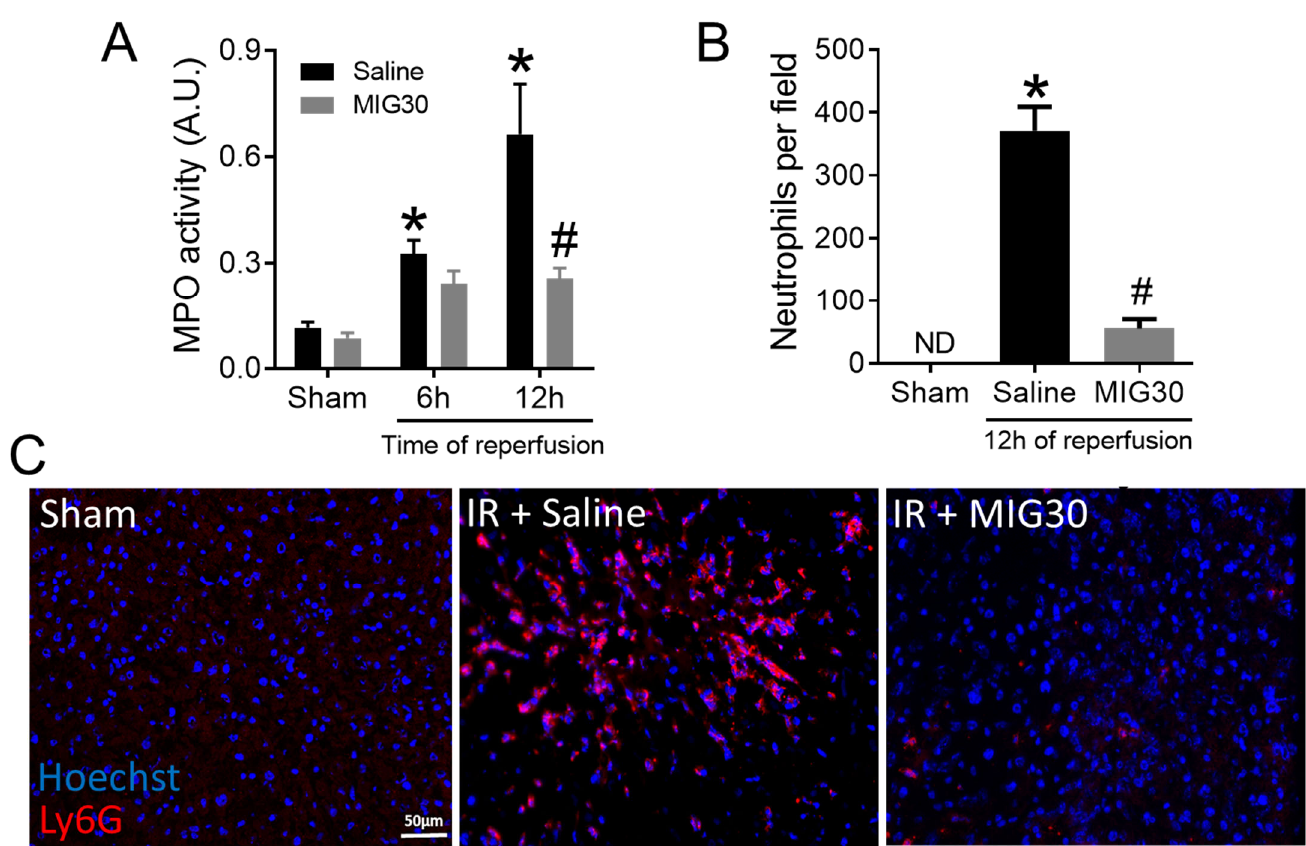
Figure 3. MIG30 treatment impairs neutrophil recruitment during liver IRI. ( A ) Liver MPO activity in mice subjected to liver ischemia-reperfusion injury (IRI). Sham operated mice were used as control. IRI mice were treated i.v. with saline vehicle or with MIG30 (100 µ g 15 min before the reperfusion and again 6 h later). ( B , C ) Immunostaining of liver cryosections with anti-Ly6G to show recruited neutrophils. Neutrophils (Ly6G + ) are shown in red and Hoechst-stained nuclei in blue. ( B ) The data shown are the averaged number of neutrophils per field of view. ( C ) Representative photomicrographs of Ly6G + neutrophils in sham, mice subjected to IR and treated with saline or IR-injured mice treated with MIG30. ND = Not detected. The data shown are the mean ± SEM; n is at least 4 mice per group. * p < 0.05 vs. sham group; # p < 0.05 vs. saline ‐ treated mice. Scale bar = 50 μ m.